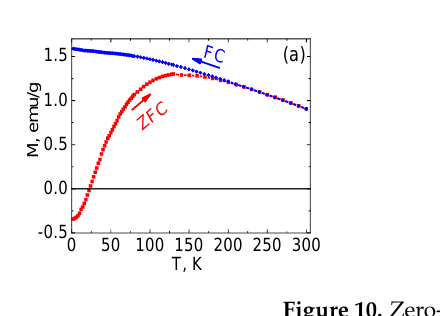
Table S3. The samples prepared by the heat-up method at 200 ◦ C and 280 ◦ C and by the injection method at 280 ◦ C were designated as H 200 , H 280 , and I 280 , respectively.